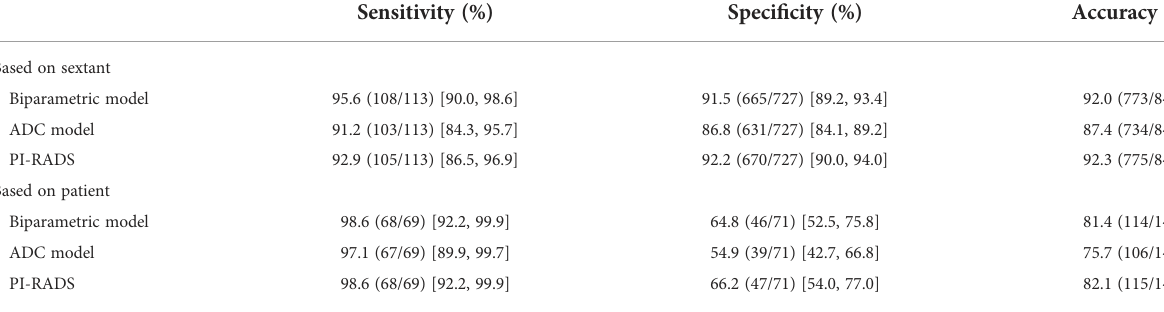
PI-RADS, Prostate Imaging Reporting and Data System. Data in brackets are 95% CIs.